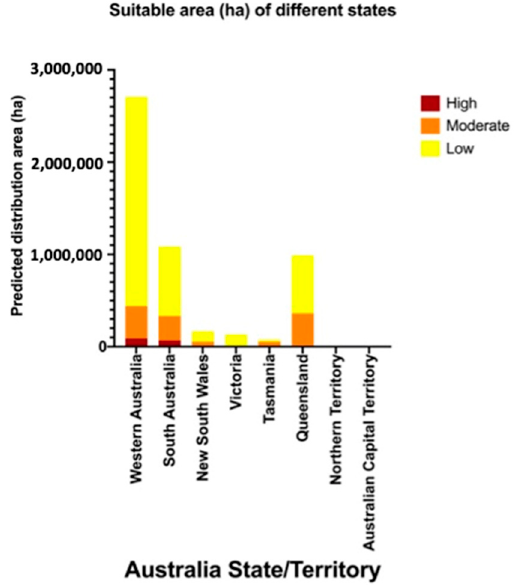
Figure 3. Potential establishment regions for Thaumatotibia leucotreta in Australia in relation to suitability of land use (cultivation).